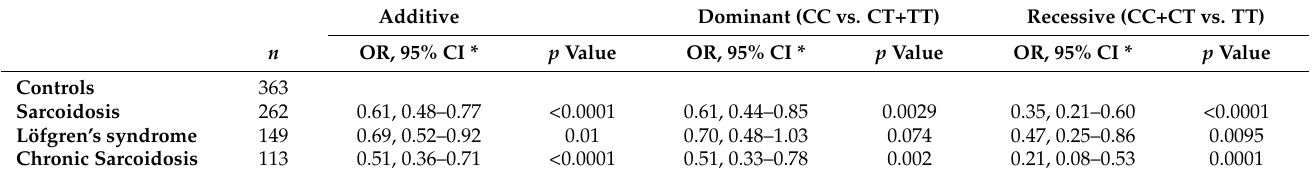
Table 3. Analysis of genetic models possibly underlying the association between ANXA11 rs1049550 and